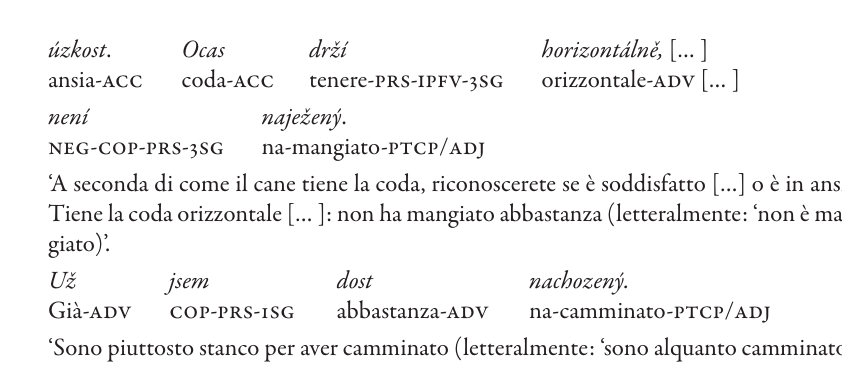
Figura 4 . Rappresentazione della struttura eventiva associata alle costruzioni con i